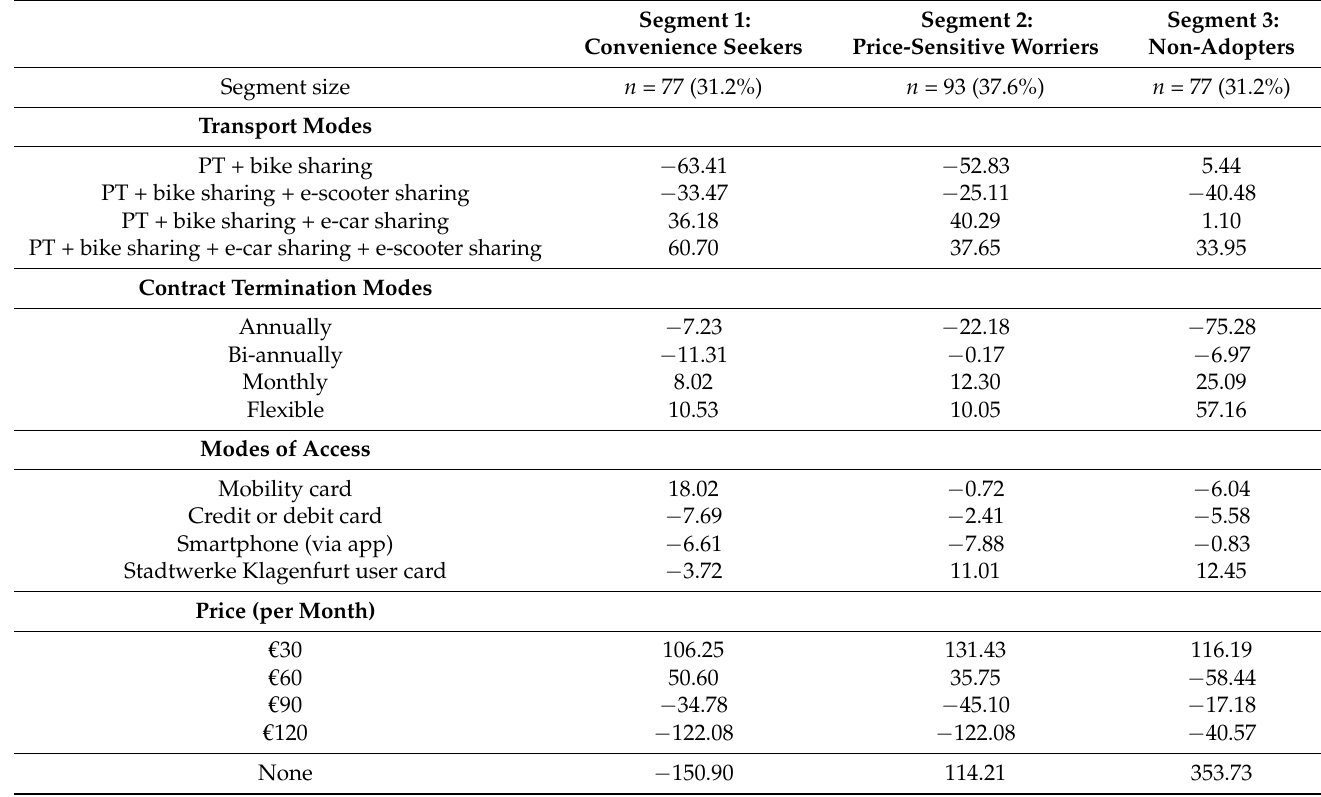
Table 4. HB model estimation of mean utility values per segment.